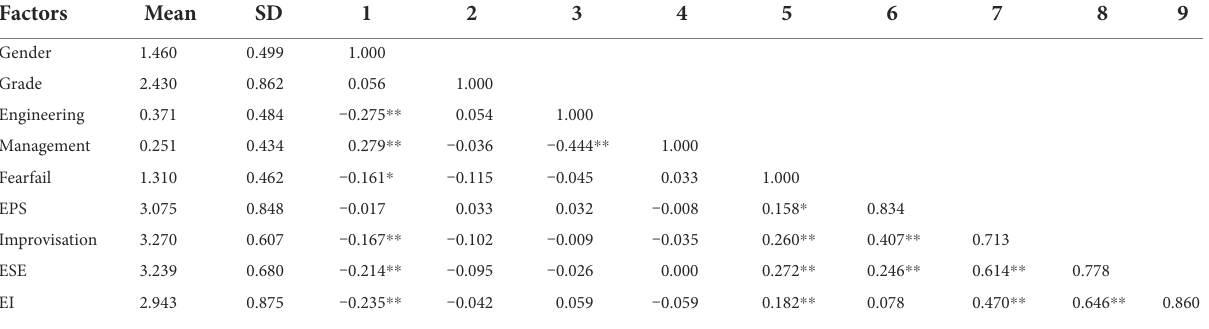
TABLE 3 | Variables mean, standard deviation and